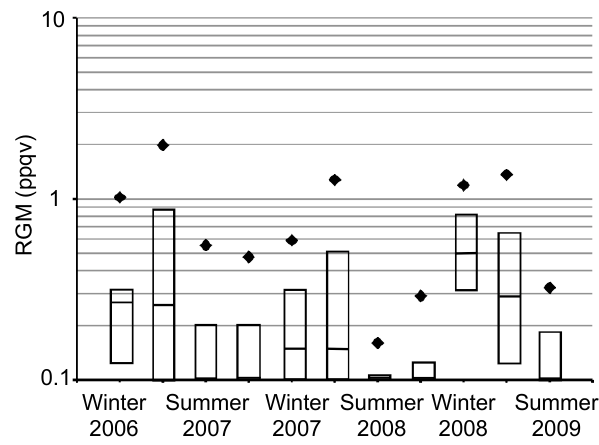
Fig. 4. Seasonal variations in RGM at TF. Each box encompasses the 25th to 75th percentiles and the solid horizontal line within each box represents the median value. The black diamonds indicate the 90th